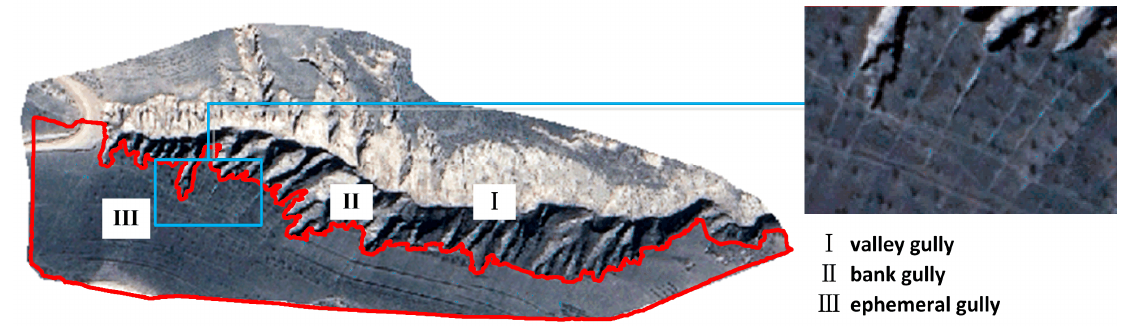
Figure 3. Ephemeral gullies and their location in a gully system in a high-resolution image.